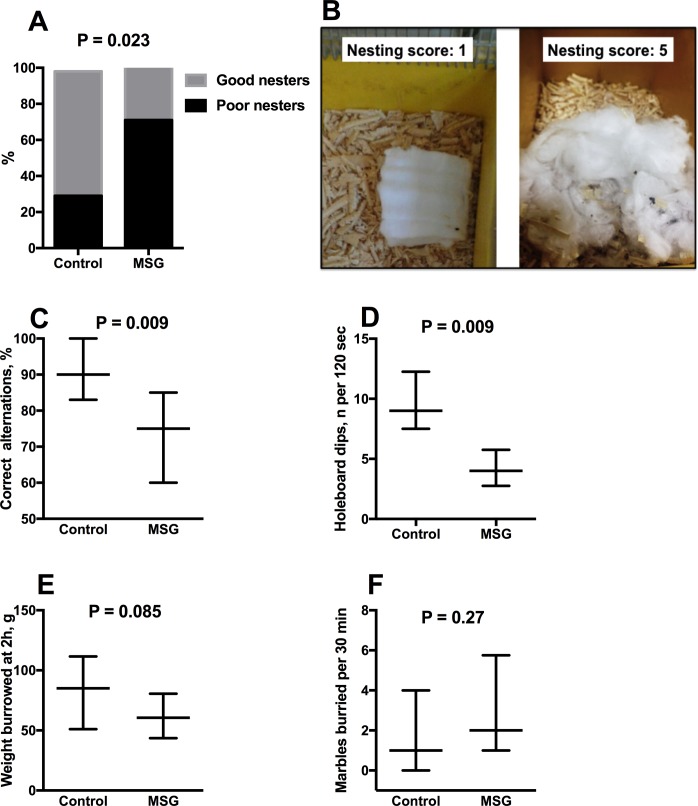
Behavioural test scores in MSG-treated rats and controls.A; percentage of poor nesters (see Methods for definition and score details) in monosodium-glutamate (MSG)- treated and control groups at age 10 weeks, compared by Fisher’s exact test. B; a typical poor nest (flat, >90% untouched) and a typical good nest (>90% shredded with walls and a central crater) from the MSG and control groups respectively. C-F; effect of MSG treatment on spontaneous T-maze alternation (C), and species-typical behavioural test scores (D-F) at age 10–12 weeks. Values (C-F) are median (25th, 75th percentiles) from N = 12 MSG mice and N = 12 controls. P values are from Mann-Whitney U test.